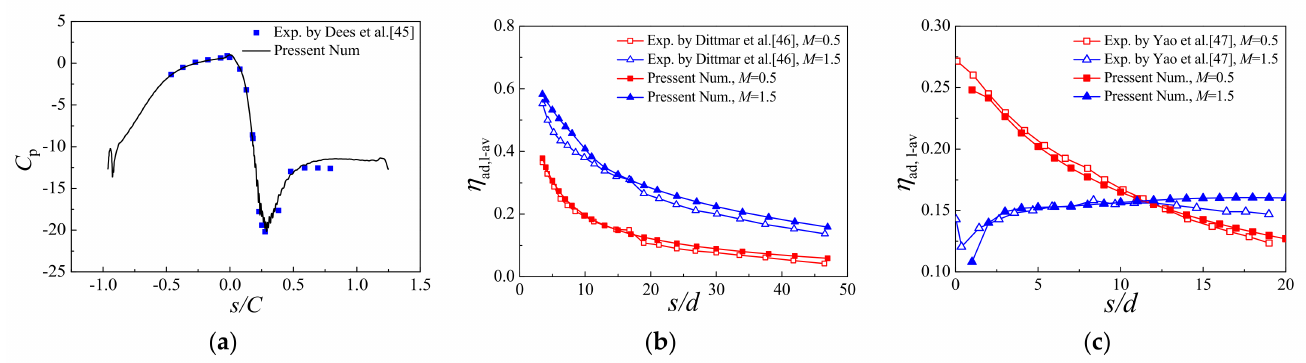
Figure 5. Validation of the computational scheme. ( a ) static pressure coefficient distribution, ( b ) fan-shaped hole film cooling on the pressure side, ( c ) DJFC on a flat